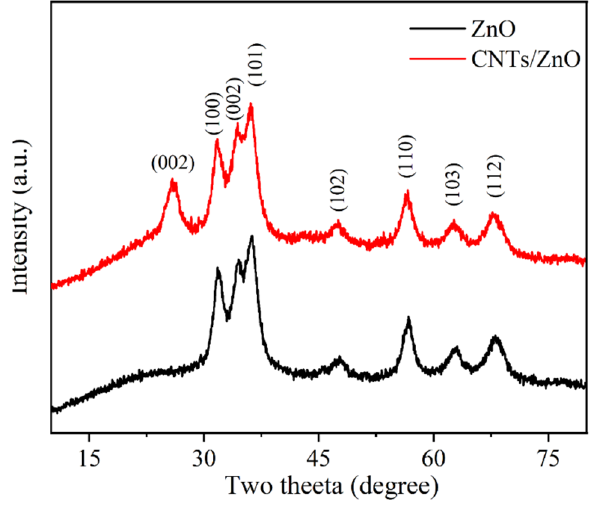
Figure 3. XRD analysis of ZnO − NPs and CNTs/ZnO composite.